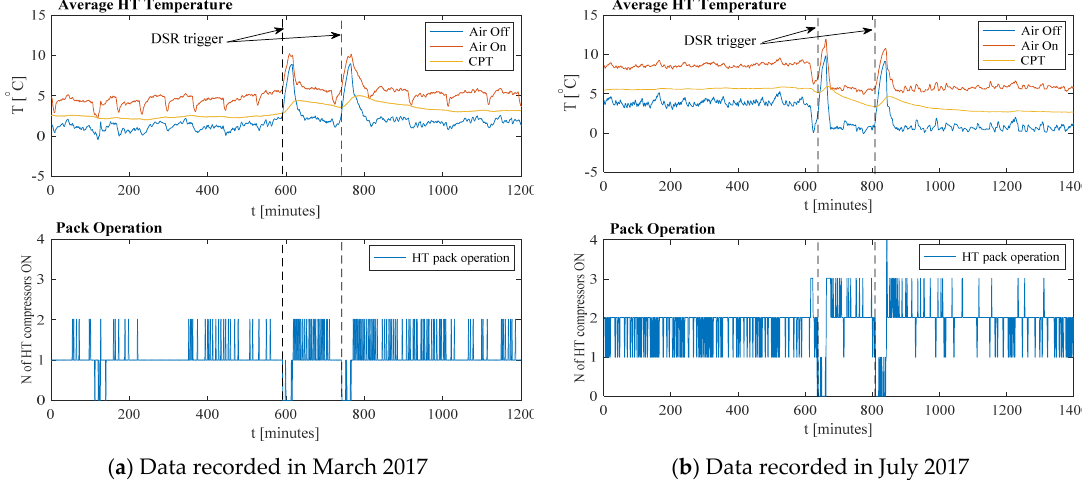
Figure 9. Average HT case temperature vs duty profile of HT compressors.